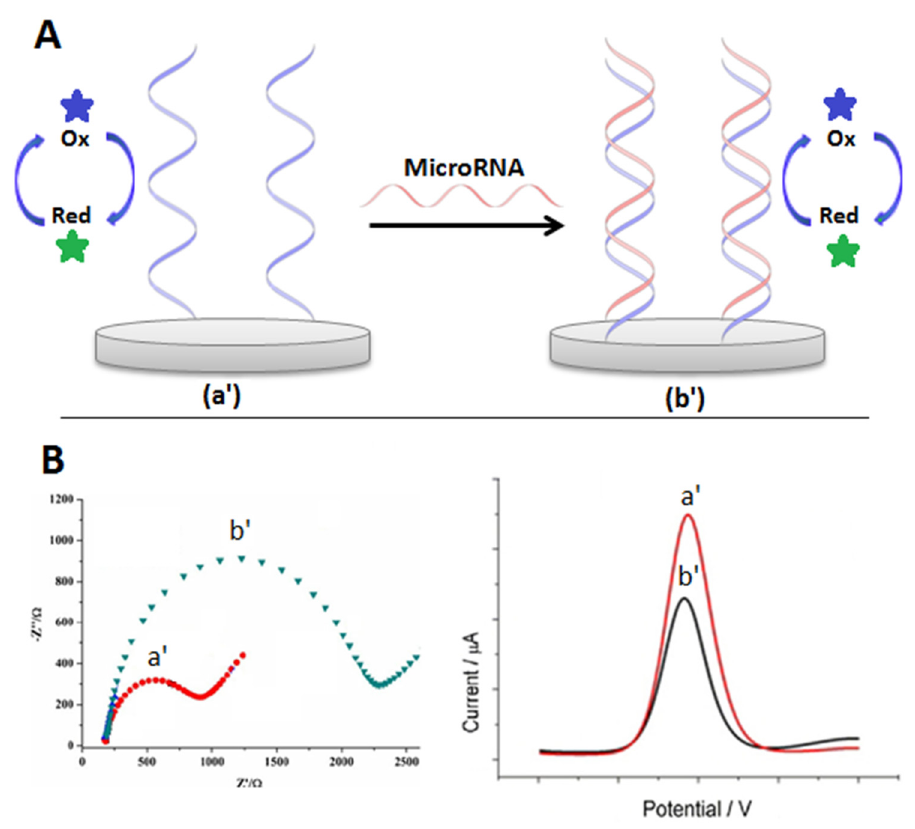
Figure 14. ( A ) Pricipale of electrochemical biosensors based on free RedOx indicator ( a’ ) before and ( b’ ) after hybridizition. ( B ) EIS and DPV response of the electrochemical biosensor based on free RedOx indicator ( a’ ) before and ( b’ ) after hybridization.